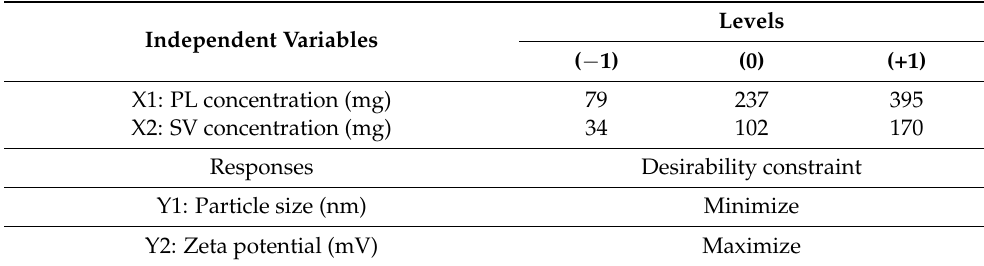
Table 1. Independent variable levels and response constraints utilized in the 3 2 factorial design for the optimization of THQ-PL-SV phytosomes.